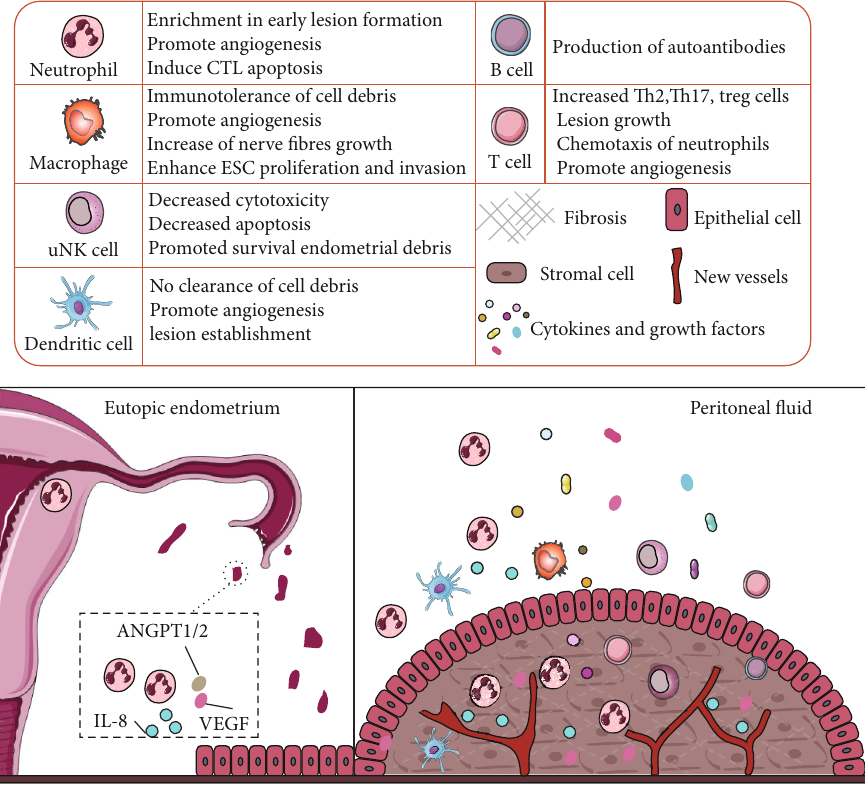
Figure 2: The function of immune cells in the microenvironment of endometriotic lesions. During menstruation, according the theory of retrograde menstruation, live endometrial debris fi rst returns to the peritoneal cavity, containing a large number of neutrophils, cytokines (IL-8), and angiogenic factors (VEGF and ANGPT1/2), which interact with various in fi ltrative immune cell populations and promote endometrial cell adhesion and cell proliferation. Under the in fl uence of systemic and local abdominal immune dysfunction, immune cells and immune mediators promote the establishment and survival of lesions. The table above outlines the role of each immune cell type in the pathophysiology of